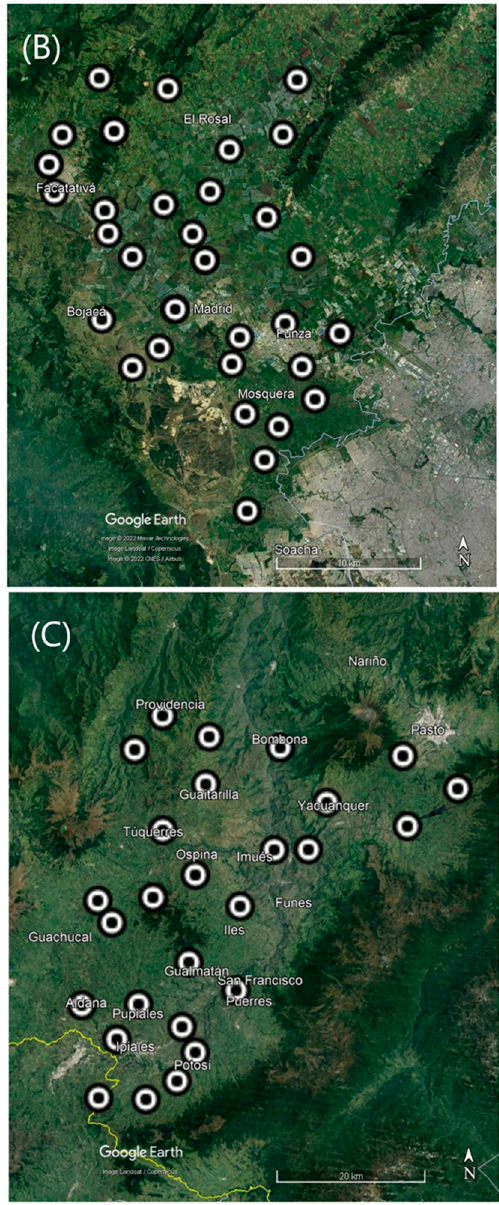
Figure 2. Sampling strategy in the departments of ( A ) Antioquia, ( B ) Cundinamarca, and ( C ) Nariño, Colombia. Each of the white points represents a location where a soil sample was collected for Plasmodiophora brassicae detection and quantification by conventional and quantitative PCR, respectively. Cruciferous crops and weeds (if present) were also visually examined for the presence of typical clubroot